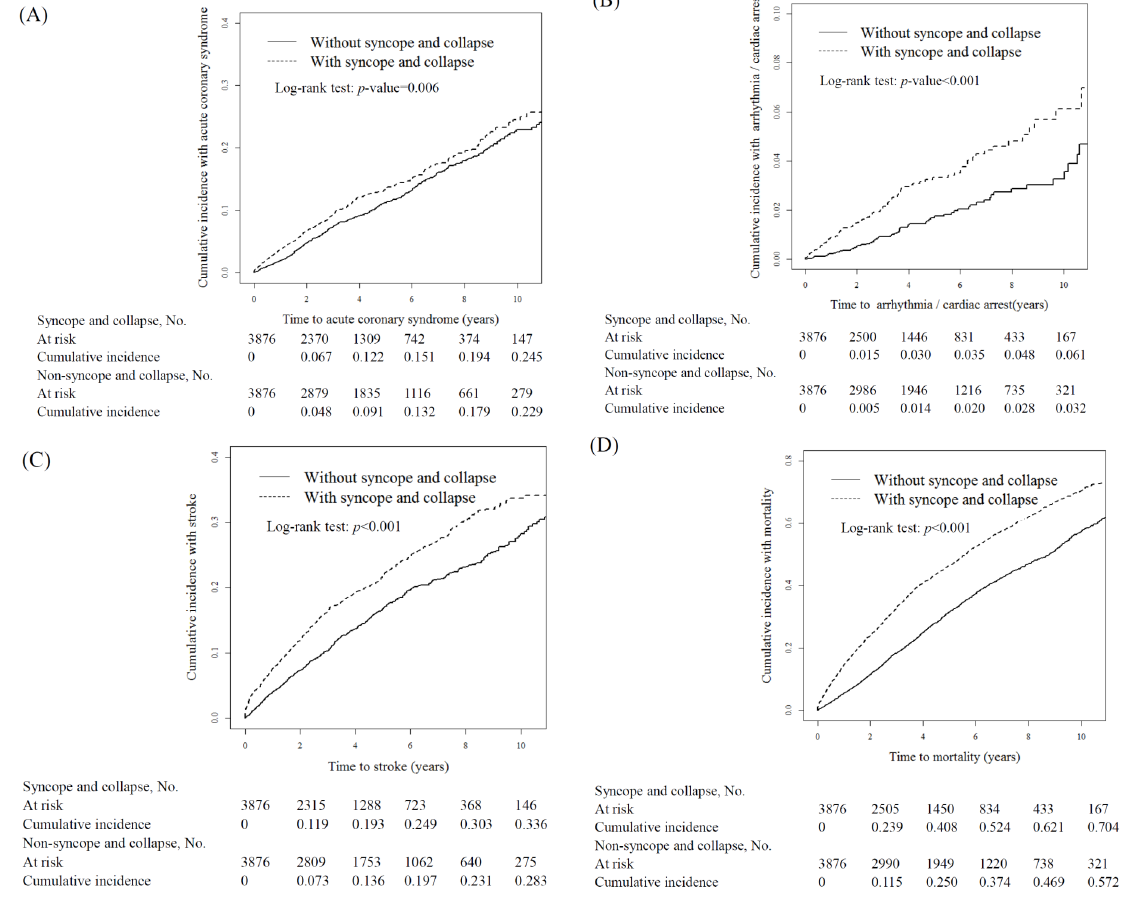
Figure 1. Cumulative incidence between patients undergoing dialysis with and without SC for the events of ( A ) ACS; ( B ) arrhythmia or cardiac arrest; ( C ) stroke; and ( D )